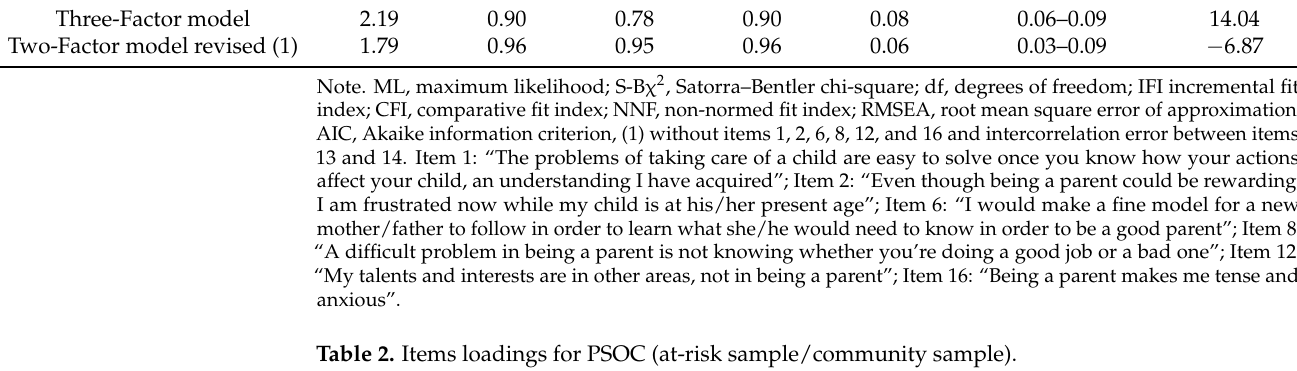
Table 2. Items loadings for PSOC (at-risk sample/community